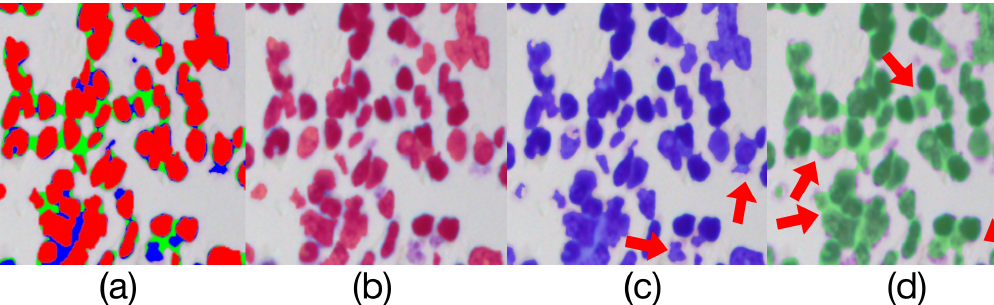
Figure 13. Comparison of model outputs and ground truth. ( a ) is composed of the other three figures above stacked from top to bottom, where the predicted extra areas are clearly seen. The red area in ( b ) is the manually annotated result. The blue region in ( c ) is the output of Render U-Net. The green region in ( d ) is the output of UNet3+. Some areas with incorrect predictions are indicated with red arrows in the